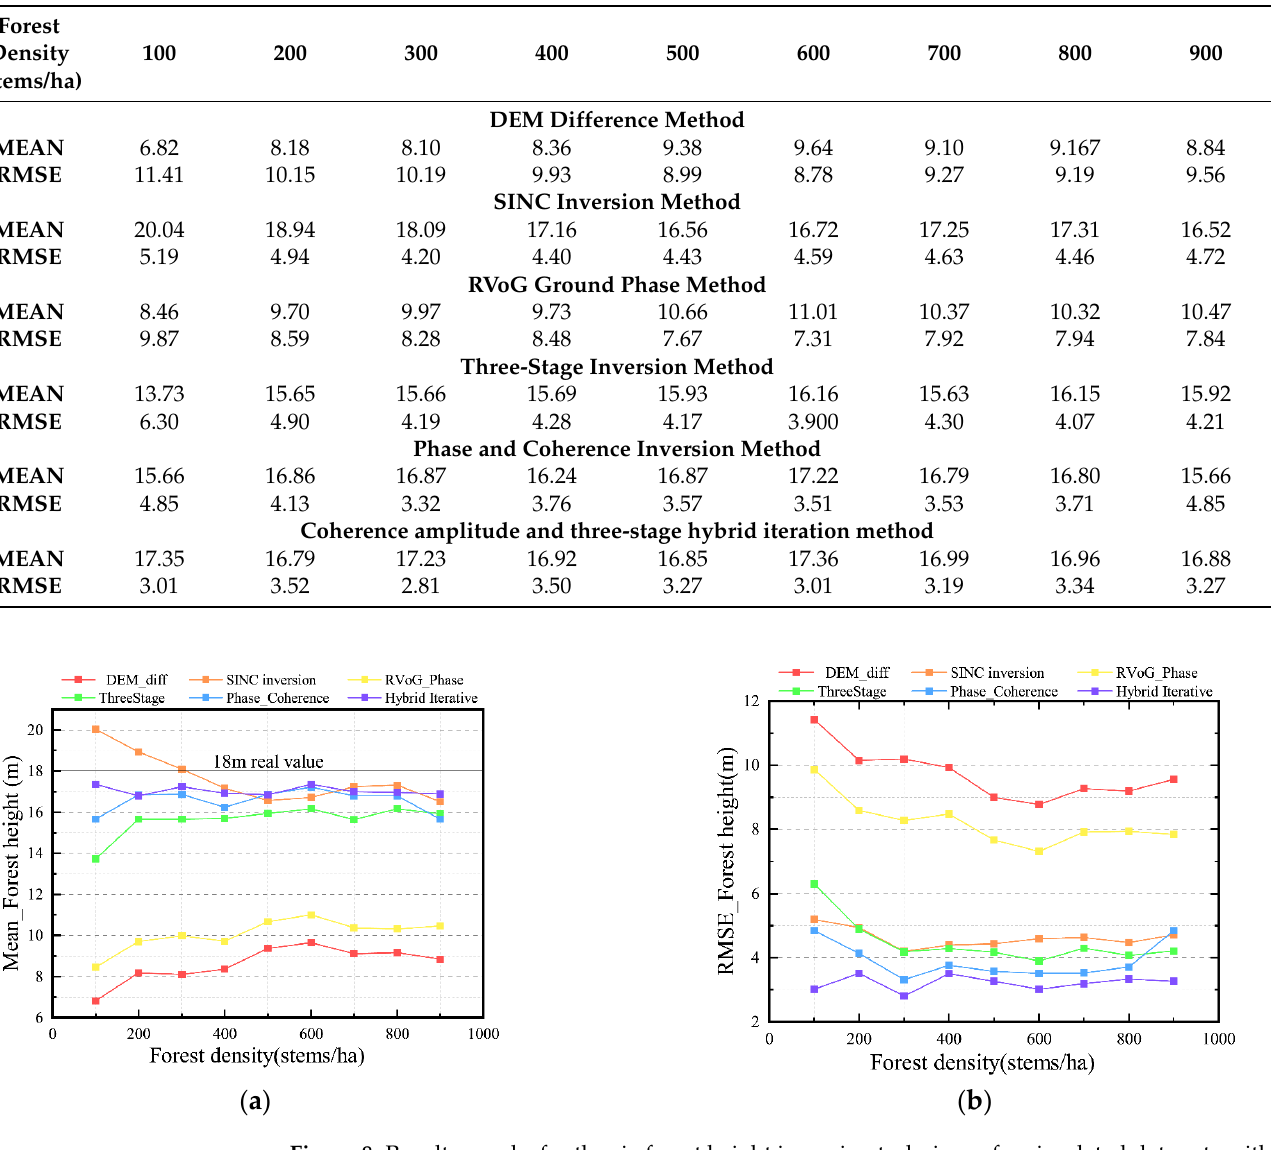
Figure 8. Results graphs for the six forest height inversion techniques for simulated data sets with 100–900 stems/ha. ( a ) Line graph of forest height ( b ) Line graph of forest height error. The red line means the DEM difference method (DEM_diff), and the orange line represents the SINC inversion method (SINC inversion). The yellow line describes the RVoG ground phase method (RVoG_Phase), and the green line represents the traditional three-stage inversion method (ThreeStage). The blue line is the phase and coherence inversion method (Phase_Coherence), and the purple line represents the coherence magnitude and three ‐ stage hybrid iterative method (Hybrid Iterative).